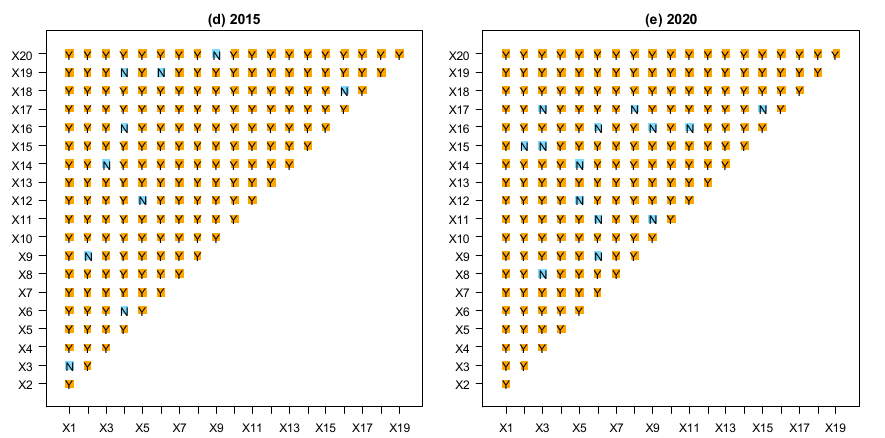
Figure 10. The ecological detector result of influencing factors of URID level of HBUA from 2000 to 2020. “Y” represents a statistically significant difference between the two variables with the confidence of 95%; “N” indicates that the two variables had no significant difference. The variables X8 and X9 in 2000 were excluded because their variances both were 0.